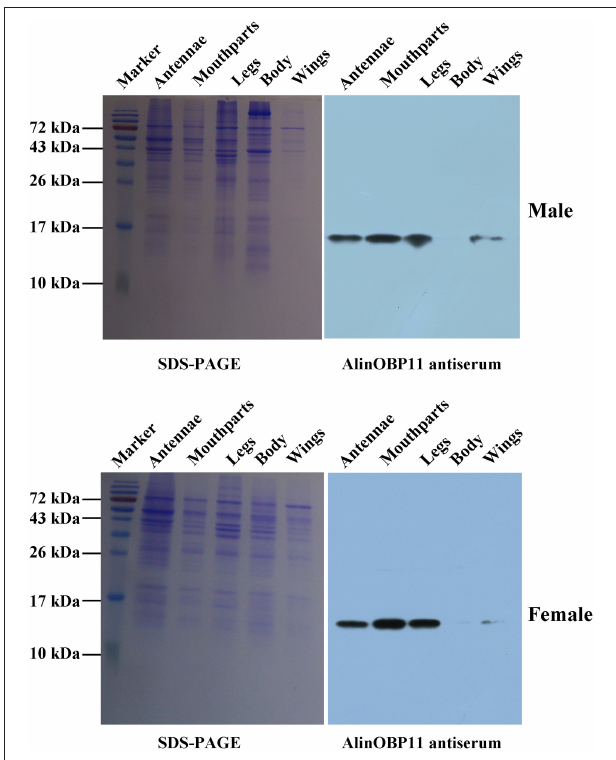
FIGURE 2 | SDS-PAGE and AlinOBP11 expression profiles among different adult tissues of both sexes assessed by western blot analysis. The results showed that AlinOBP11 was detected at both male and female adult mouthparts, legs, antennae, and weakly or even undetectably at other